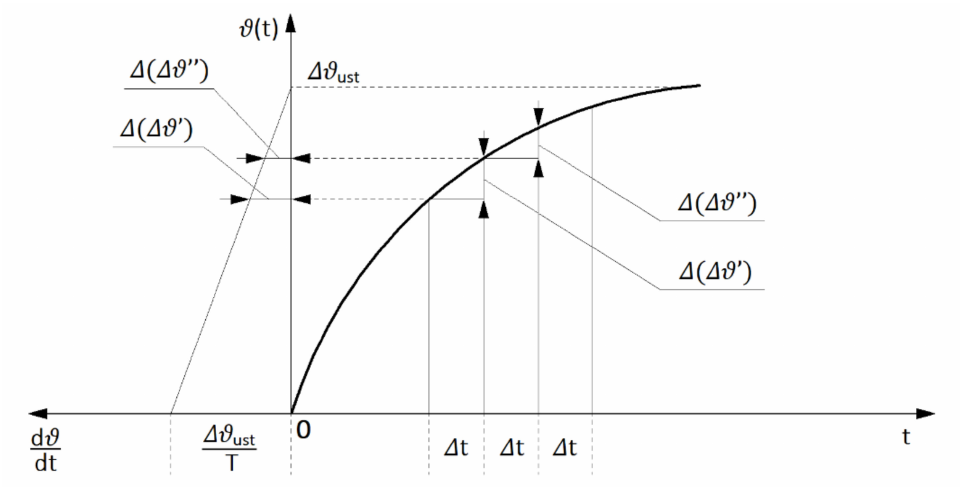
Figure 12. Graphical method of determining the value of the set temperature rise on the basis of a partial